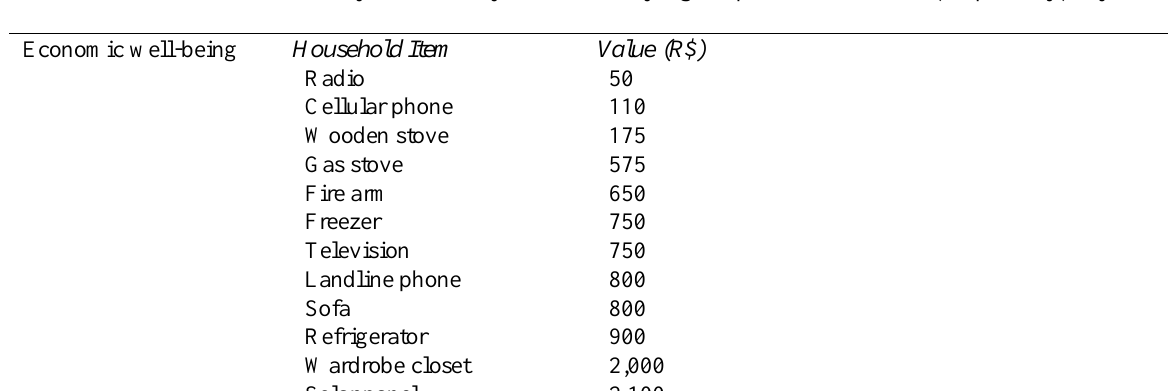
Table A2.2. ‘Social Capital’ measures perceptions of trust and support in the respondent’s relationship with their community. ‘Well-being’ measures satisfaction with life, relationships and progress within the community. For both ‘social capital’ and ‘perception of well-being’ variables, ordinal responses to individual items were converted to values and summed to create a composite score. Households with two household heads required averaging of the two individual scores to reflect the household level. ‘Economic well-being’ was based on a wealth index of household items and an average of their approximated new and used values. For each household, items owned were reported and the values of those items summed. Questionnaire items were adapted from Center for International Forestry Research (CIFOR)’s Poverty and Environment (PEN) prototype questionnaire, Annual Household Survey 2 (A2), version 4.4, September